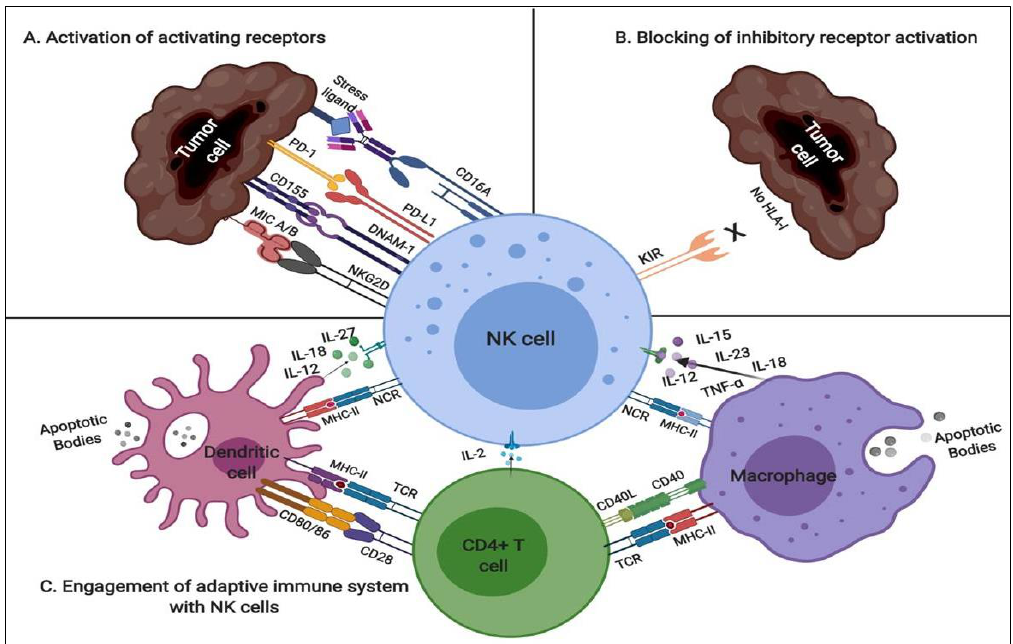
Figure 2. Schematic representation of NK cells-modulatory mechanism: ( A ) Mature NK cells express a range of germline-encoded activating and inhibitory receptors. The interaction of activating receptor of NK cells to their cognate ligand, either constitutively expressed or induced on tumor cells during transformation, activates the cytotoxic downstream signaling in NK cells; ( B ) As per the missing-self hypothesis, inhibitory receptor KIRs include KIR2DL1 – 3, KIR2DL5, and KIR3DL1 – 3, fails to engage with self-human leukocyte antigen (HLA) complex due to its absence and prevent the downstream inhibitory signaling; ( C ) The antigen-presenting cells (APCs) such as Macrophage and Dendritic cells process and present tumor antigen through MHC-II molecules and release distinct interleukin (IL) cytokines, encourage NK cells survival and activation; CD4+ T cell release IL-2 which is a potent inducer of NK cell proliferation and enhances cytotoxicity. (T-cell receptor (TCR), major histocompatibility complex class II molceules (MHC-II), natural cytotoxicity receptors (NCRs), tumor necrosis factor-alpha (TNF- α)).